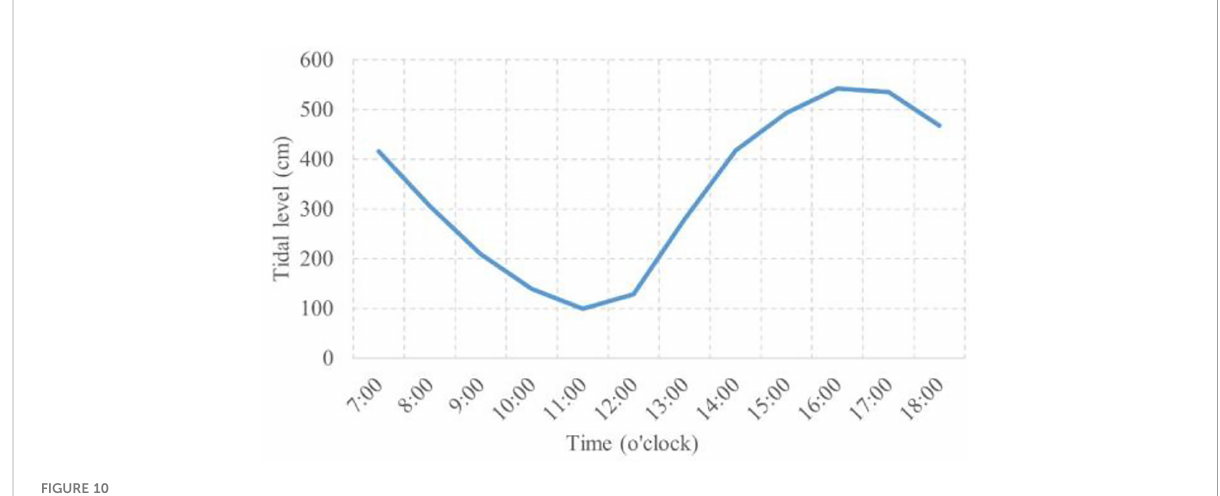
FIGURE 10 Tidal changes in the study area (April 13,